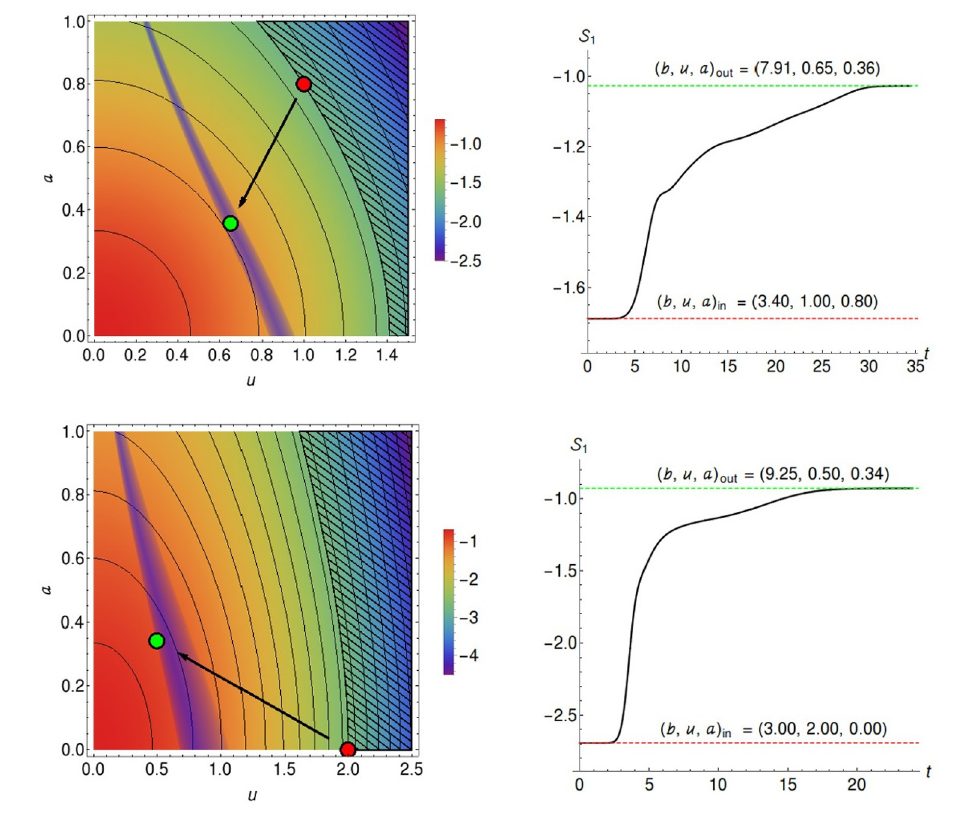
Figure 10 . Total entropy growth in symmetric 2 ! 1 ! 2 collisions. Left : coloured-contour plot for the total entropy of con(cid:12)gurations with velocity and spin ( u; a ), with a given value of J=M . Red and green dots indicate the initial and actual (cid:12)nal states in the dynamical evolution. The hashed part marks (cid:12)nal states forbidden by the second law. The purple band are states with impact parameter in the geometric range (3.24). We see that the actual (cid:12)nal states lie very close to (although not exactly at) the maximum entropy with b in this range. In particular, larger values of a out and smaller of u out would be entropically very disfavoured. Right : evolution in time of S 1 along the simulation. The initial and (cid:12)nal parameters are (top) ( b; u; a ) in = (3 : 4 ; 1 : 0 ; 0 : 8), ( b; u; a ) out = (7 : 9 ; 0 : 65 ; 0 : 36) and (bottom) ( b; u; a ) in = (3 : 0 ; 2 : 0 ; 0 : 0), ( b; u; a ) out = (9 : 25 ; 0 : 5 ; 0 :